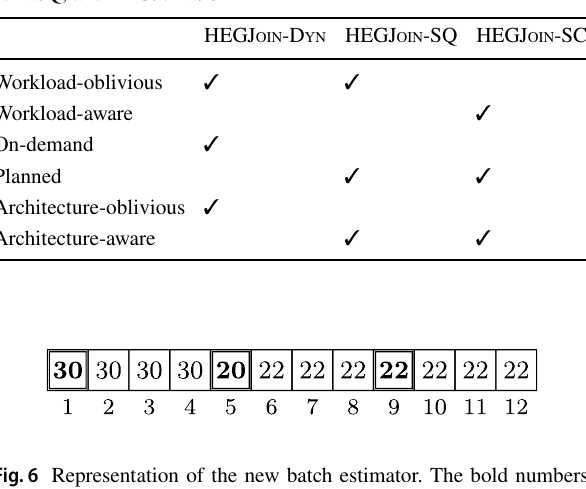
Table 1 Summary of the different properties of HEGJ oin -d yn , HEG-